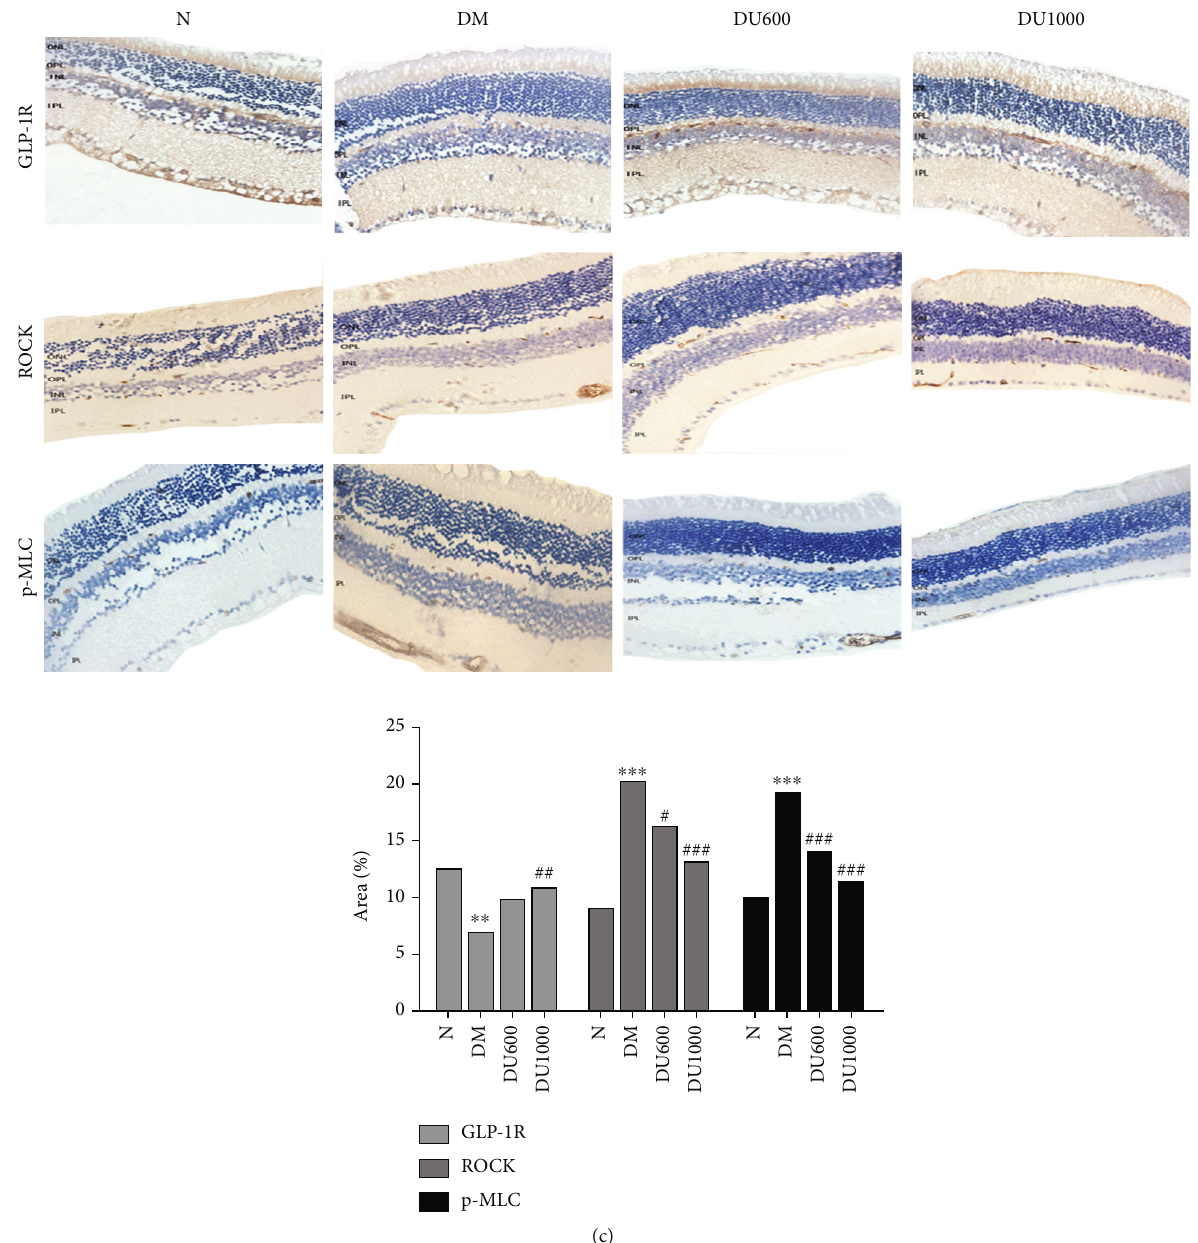
Figure 5: Reduced ROCK/p-MLC expression and increased GLP-1R expression through GLP-1RA treatment. (a) Western blot analysis of retinal GLP-1R protein in four groups.(b, c) Immuno fl uorescence and immunohistochemistry analysis of retinal GLP-1R ROCK/P-MLC expression in four groups and histogram comparisons (40 × ). Annotation: compared with the normal group, ∗ p < 0 : 05 , ∗∗ p < 0 : 01 , and ∗∗∗ p < 0 : 001 ; compared with the DM group, # p < 0 : 05 , ## p < 0 : 01 , and ### p < 0 : 001